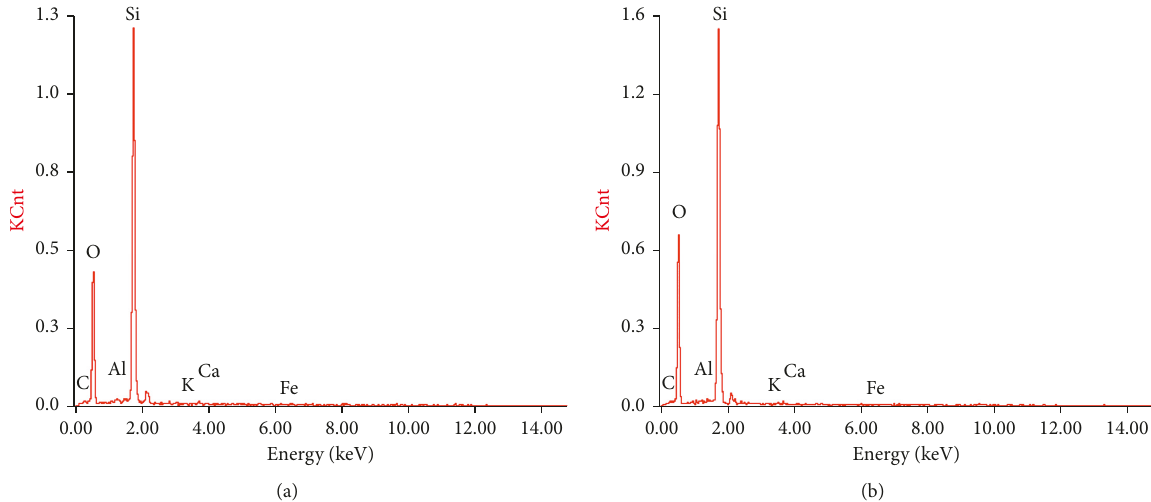
Figure 8: Energy spectrums of paste from Figures 6(b) “3” and 6(c) “4”: (a) EDS from Figure 6(b) and (b) EDS from Figure 6(c).